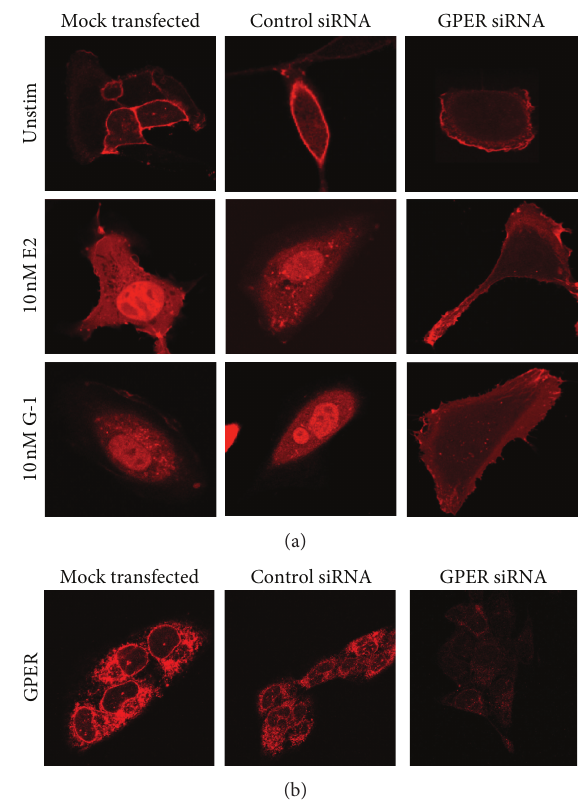
Figure 4: GPER mediates PI3K activation in Hec50 cells. (a) Hec50 cells were transfected with no siRNA (mock transfected), control siRNA or siRNA targeting GPER (GPER siRNA), and the PH- RFP reporter. Transfected Hec50 cells were stimulated with vehicle, estrogen (10nM E2), or G-1 (10nM). (b) Hec50 cells transfected with no siRNA (mock transfected) and control siRNA or siRNA targeting GPER (GPER siRNA) were stained for GPER (with carboxy-terminal antibody) to demonstrate the specific knockdown of GPER in the GPER siRNA-treated